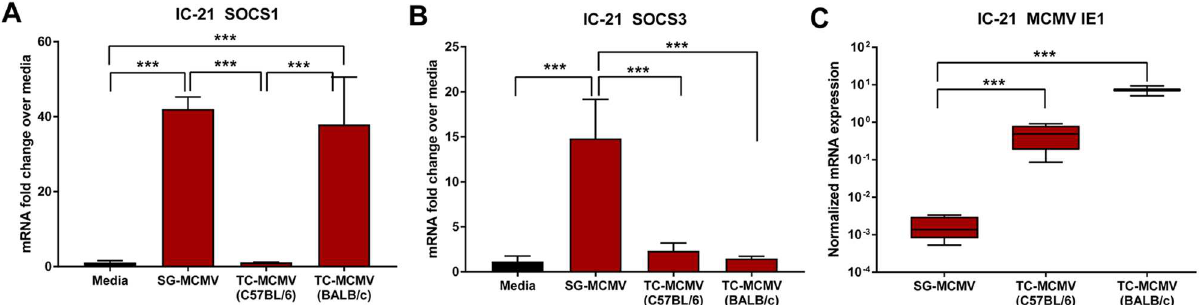
Fig 2. MCMV-related SOCS1 and SOCS3 stimulation in macrophages at 3 hpi is dependent on viral passage origin (SG-MCMV or TC-MCMV). IC-21 mouse macrophages were treated with media (baselinecontrol) or infected with SG-MCMV (from BALB/c salivary glands), TC-MCMV from C57BL/6 MEFs, or TC-MCMV from BALB/c MEFs at MOI = 3 PFU/cell. At 3 hpi, cells were harvestedand assessed for SOCS1 (A) or SOCS3 (B) mRNA by real-time RT-PCR assay by the comparative 2 - ΔΔ Ct method, with all groups relativeto the media control group. Means ± SD of at least duplicateexperimental repeats are shown. Expression of MCMV IE1 mRNA (C) of the virus- infected groupswas normalizedto GAPDH transcripts and analyzedby the comparative 2 - Δ Ct method. Minimum and maximum IE1 mRNA expressionvalues (red boxes) and means (black lines within boxes) ± SD of at least duplicateexperimental repeats are shown on a logarithmicscale. *** p < 0.001betweenbracketedgroupsby one-wayANOVA with Tukey’s post-hoc